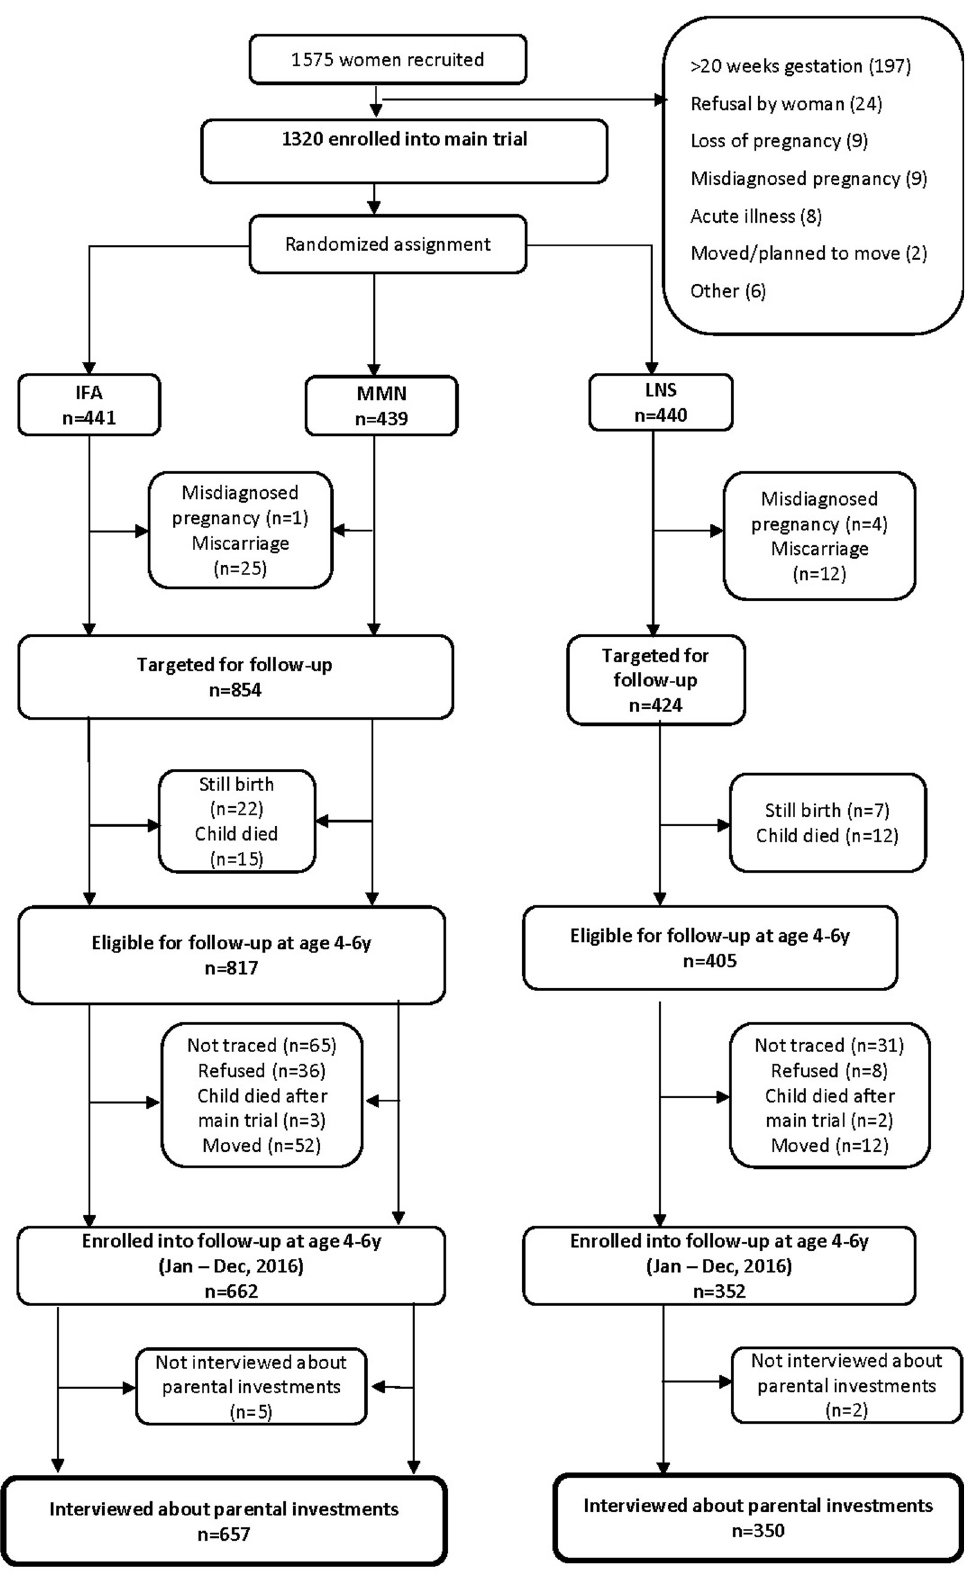
Fig 1. Study profile. IFA = iron-folic acid; MMN = multiple micronutrients; LNS = lipid-based nutrient supplements.